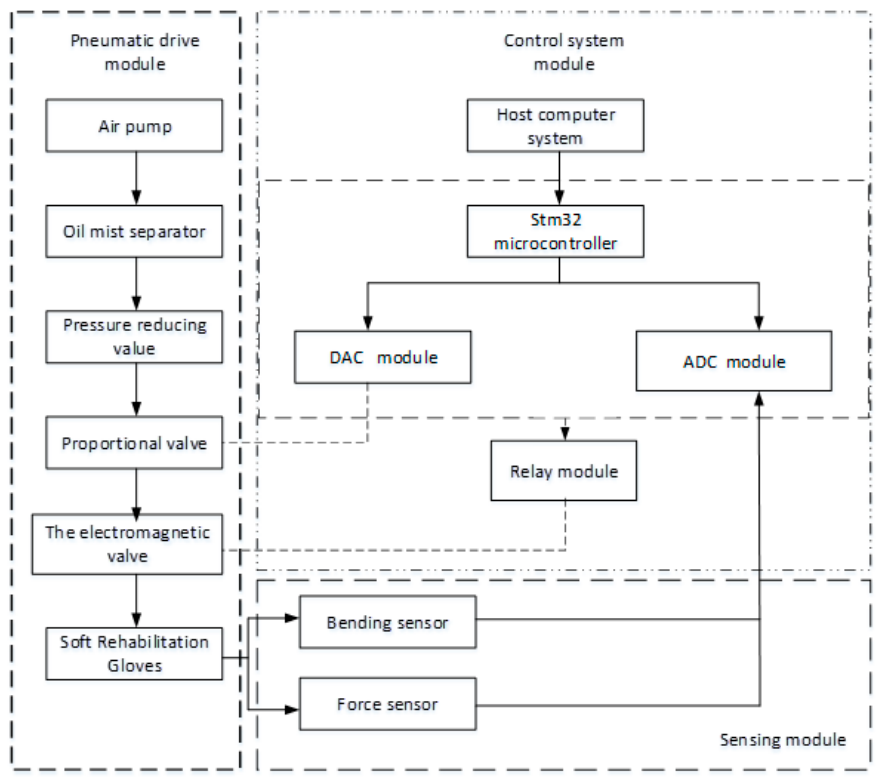
Figure 18. Schematic diagram of hardware system for SRGs.